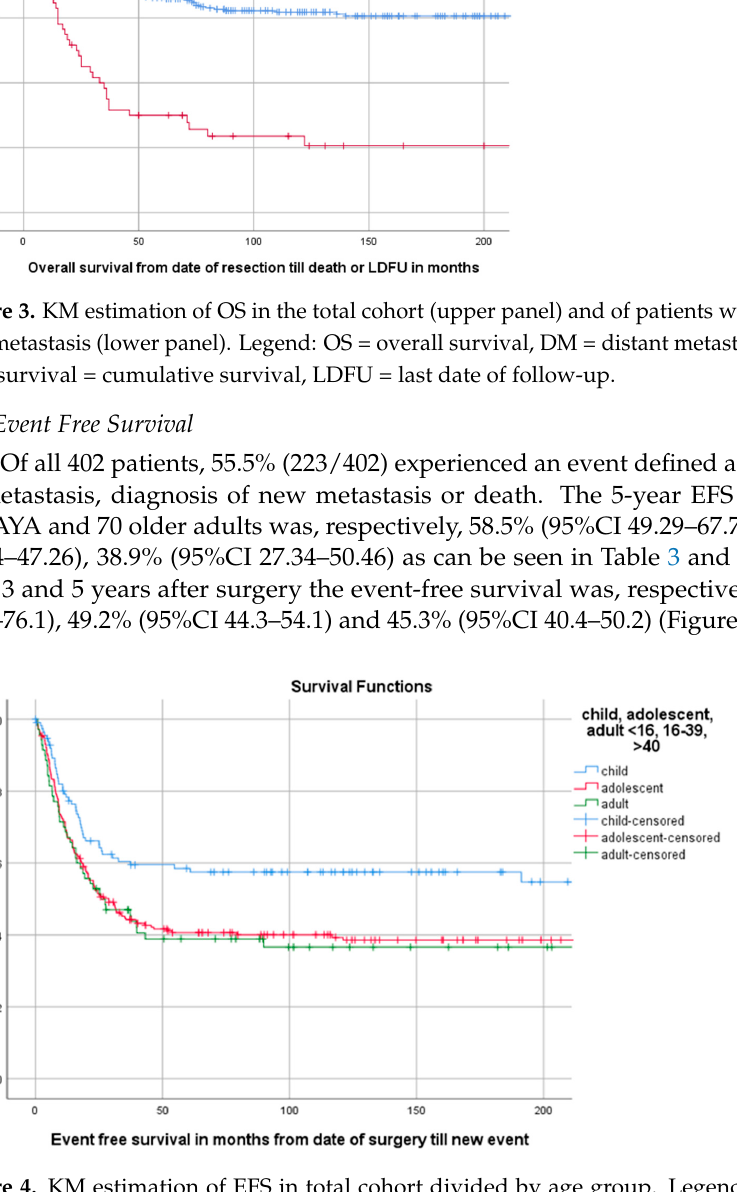
Figure 4. KM estimation of EFS in total cohort divided by age group. Legend: EFS = event-free survival, cum survival = cumulative survival.